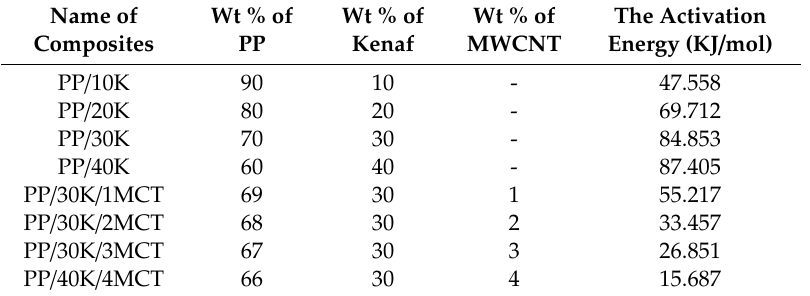
Table 2. Activation energy of the PP / kenaf / MWCNT composites with di ff erent compositions. Table 2 . Activation energy of the PP/kenaf/MWCNT composites with different compositions . Name